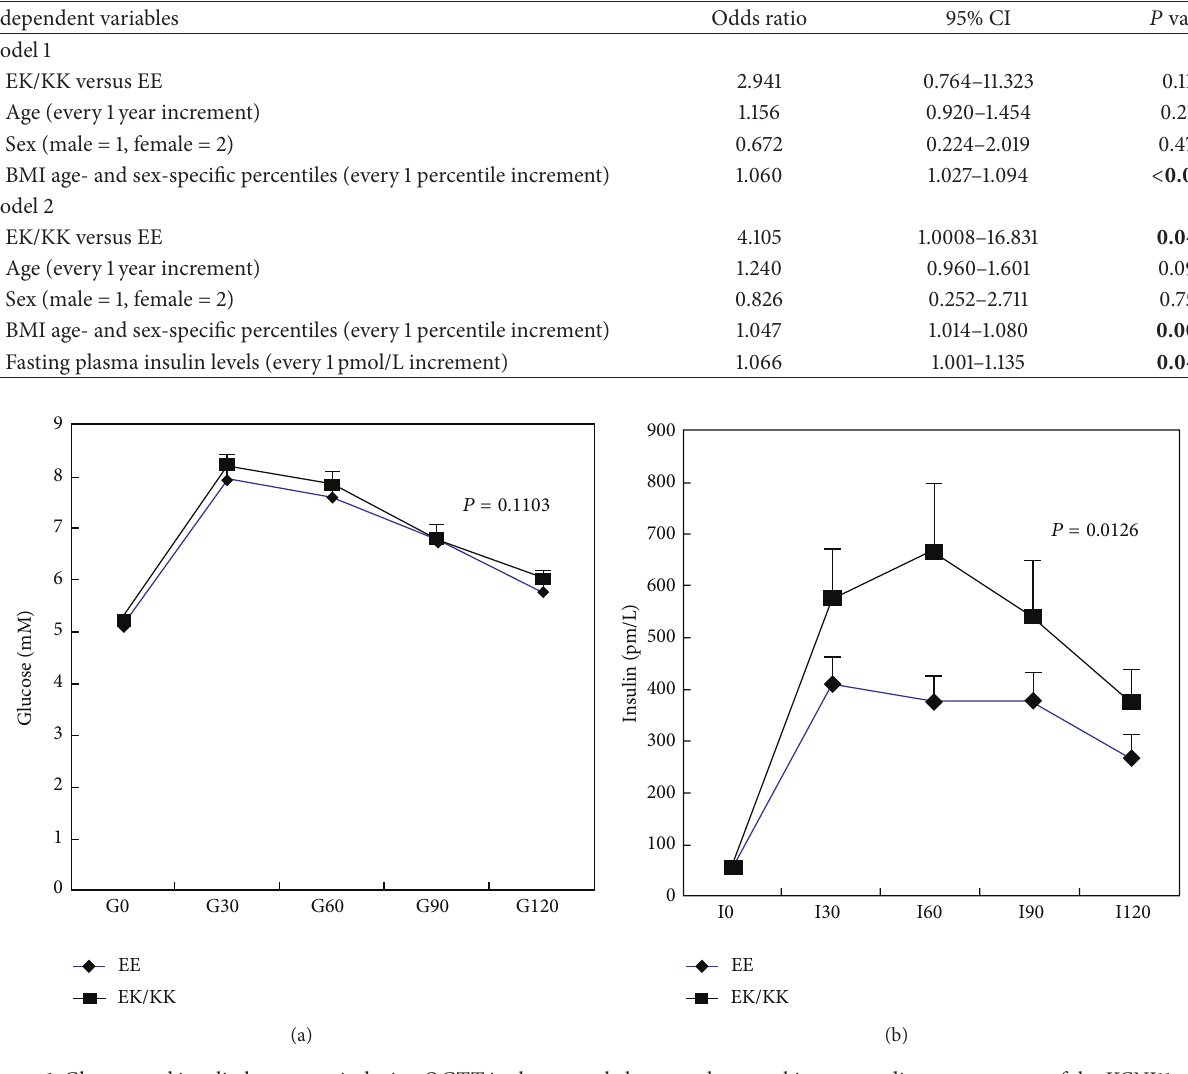
Figure 1: Glucose and insulin homeostasis during OGTT in the normal glucose-tolerant subjects according to genotypes of the KCNJ11 gene. There was no significant difference in plasma glucose levels in subjects with EE genotype compared with those with K23-allele-containing genotypes (EK or KK) (a). Subjects with EK/KK genotypes tended to have a higher level of plasma insulin level during OGTT (b). ∗ indicates significant difference between the two